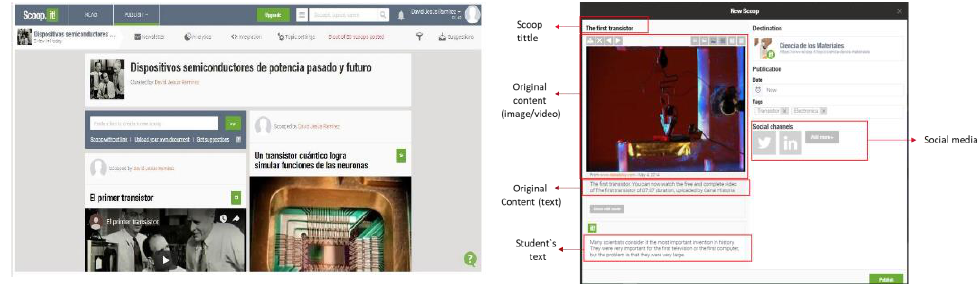
Figure 6. Example of a Scoop.it panel and a New Scoop screen for the sense making step.